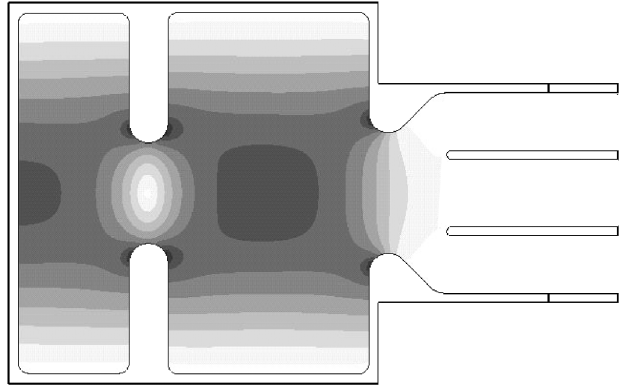
FIG. 4. Contour map of the electric field amplitude in the cavity and part of the coaxial